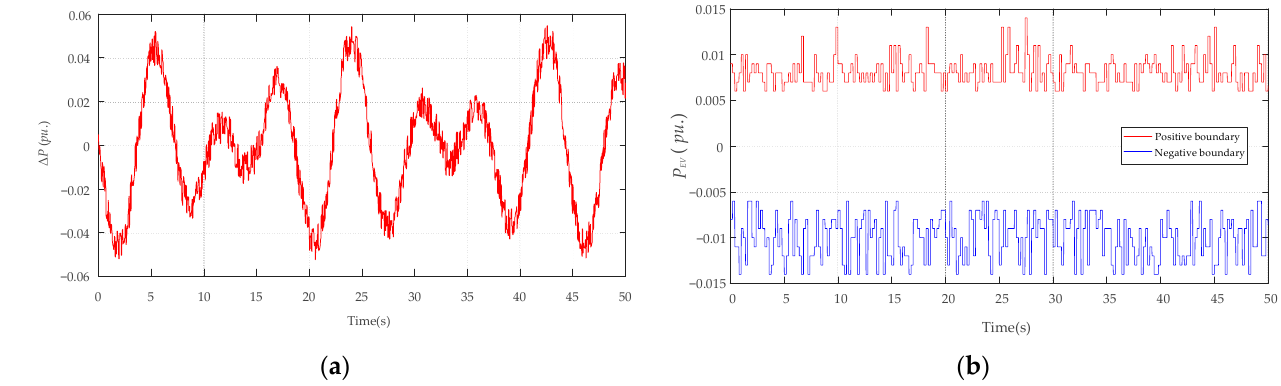
Figure 8. Random perturbation function in the pre-learning phase: ( a ) Random Function of Active Power Disturbance; ( b ) Random Function of EV Output Power